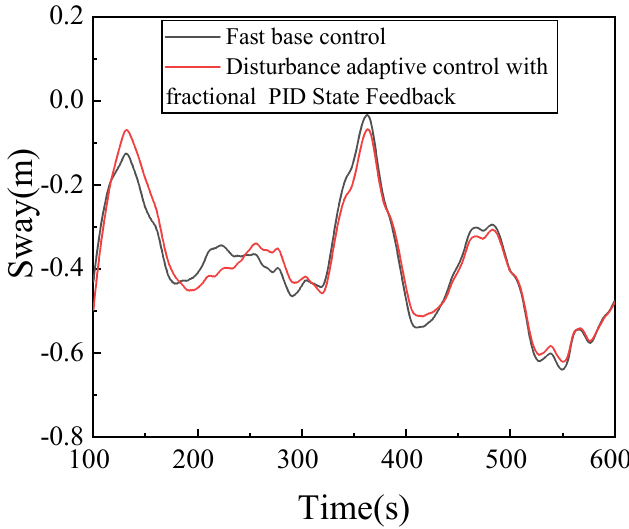
Figure 11. Comparison of heave displacement under two different control algorithms.